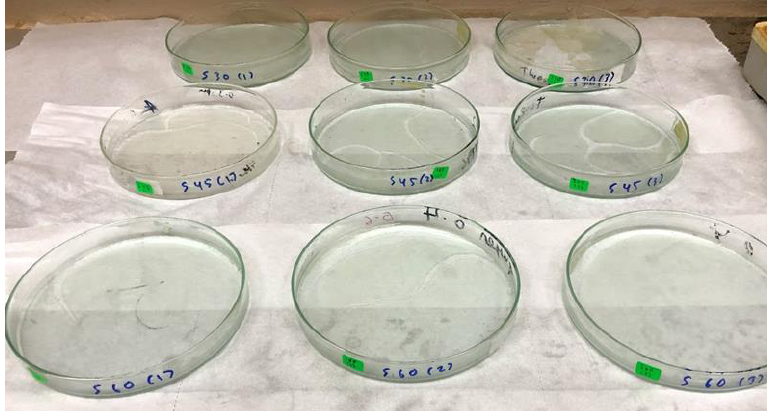
Figure 1. Fabricated cornstarch-based film with different plasticizers.